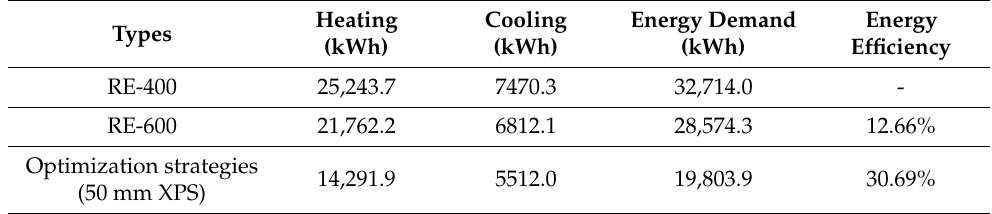
Table 10. Comparative analysis of optimization strategies.